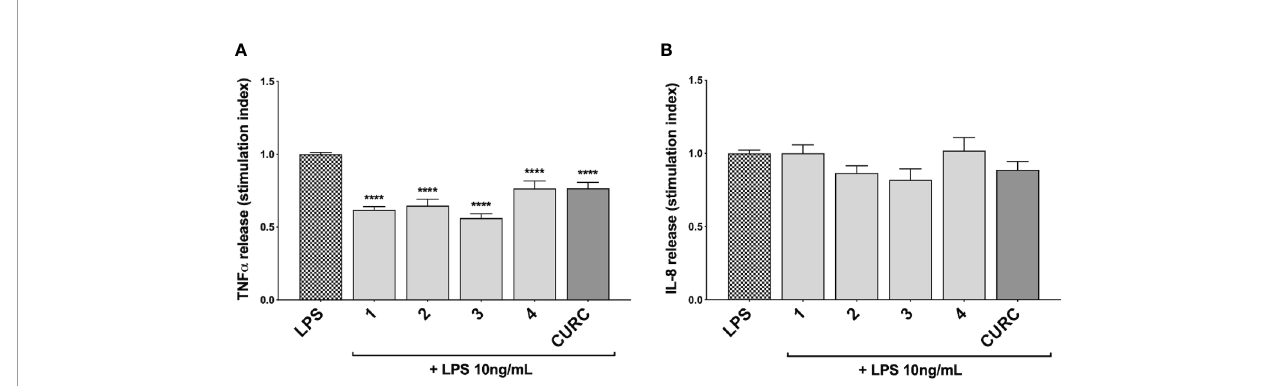
FIGURE 3 | Modulation of TNF a and IL-8 release in LPS-stimulated THP-1 cells exposed to compounds. THP-1 cells were treated with compounds 1 – 4 and CURC at a concentration of 5 m M for 24 h, and then stimulated with 10 ng/mL LPS for 3 h. TNF a (A) and IL-8 (B) protein release was measured in THP-1 supernatants by ELISA. Data are presented as means of stimulation index ± SEM. Dunnett ’ s multiple comparison test; **** p < 0.0001 versus CTR; n =